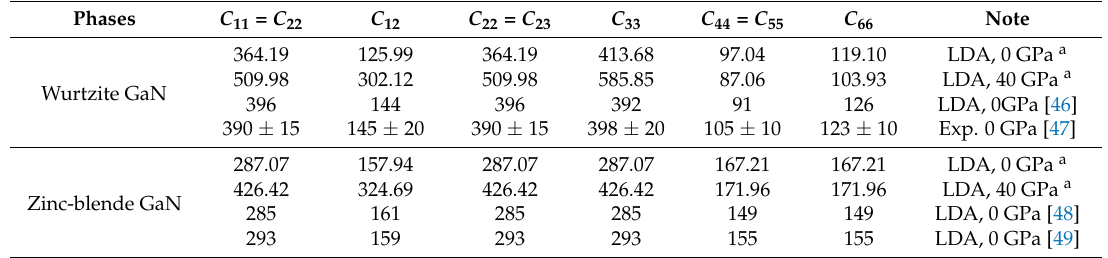
Table 2. Calculated elastic constant C ij (GPa) under pressures 0 and 40 GPa.